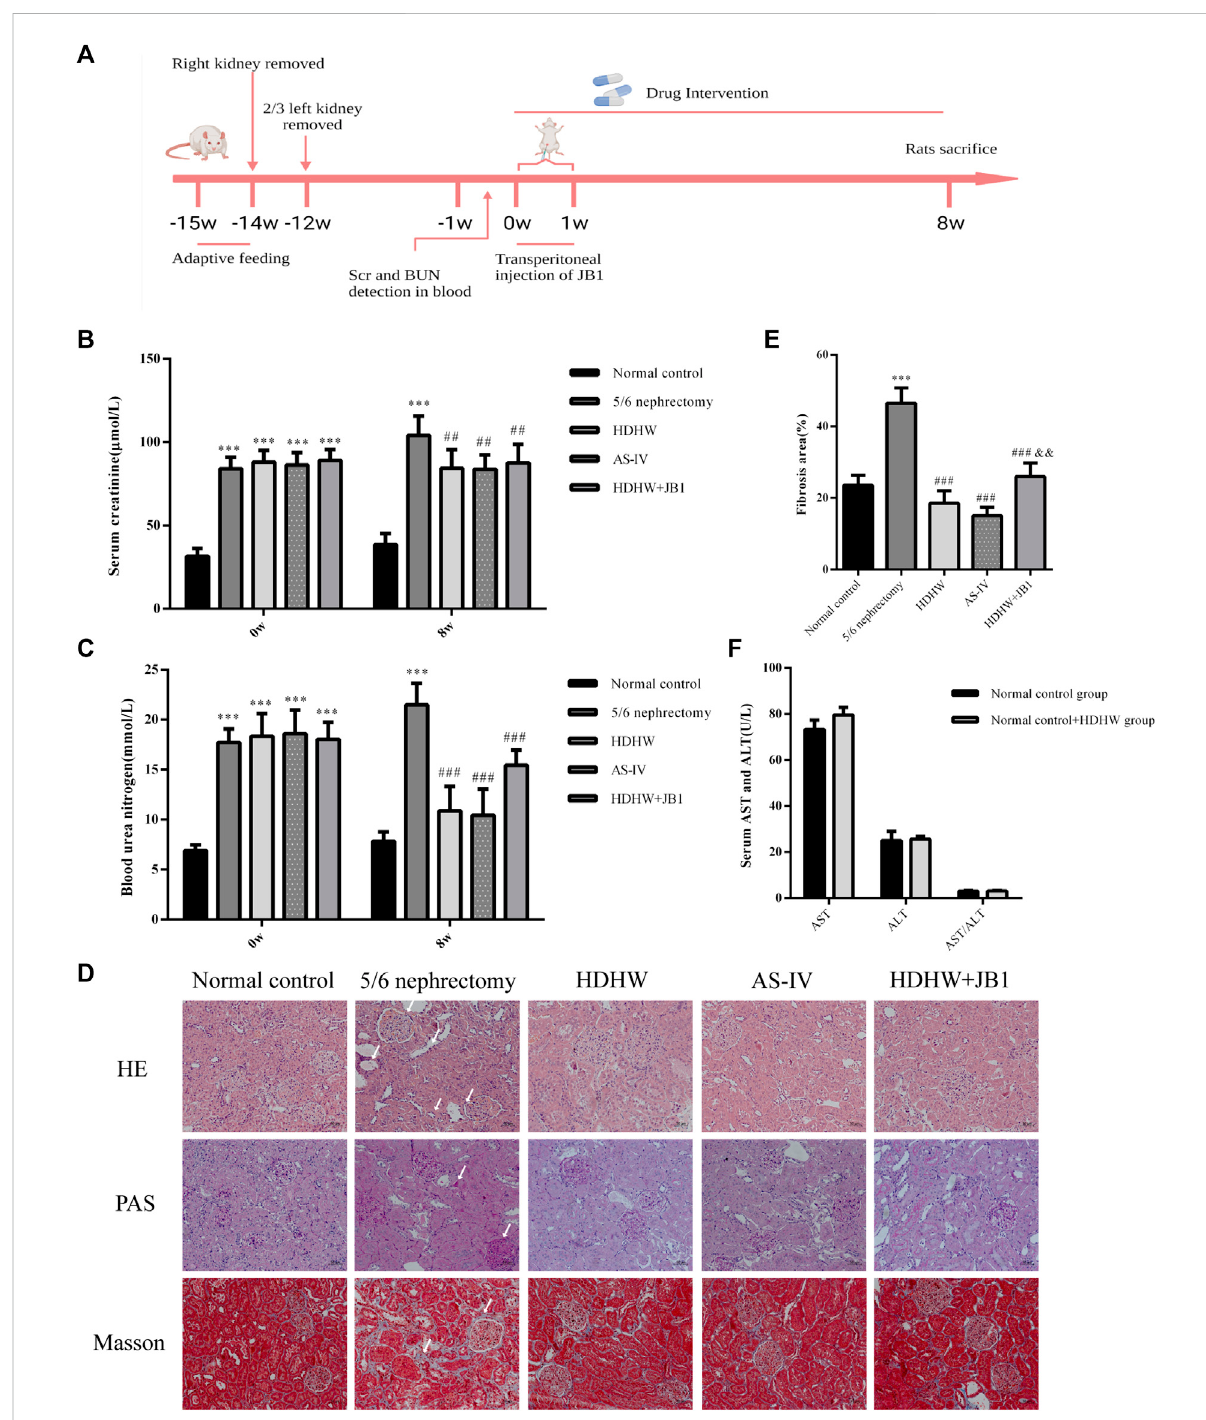
FIGURE 2 HeidihuangWan (HDHW) improves renal function and renal pathological damage in 5/6 nephrectomized rats. (A) Timeline of animal experiments. (B) Serum creatinine (Scr) and (C) blood urea nitrogen (BUN) levels before and after 8 weeks of drug intervention. (D) Hematoxylin- Eosin (HE), Periodic Acid-Schiff (PAS), Modi fi ed Masson ’ s Trichrome (Masson) staining. Collagen fi ber deposition was observed in the 5/ 6 nephrectomy group (arrows). (E) The degree of renal fi brosis was calculated using ImageJ software. (F) Serum aspartate aminotransferase (AST) and alanine aminotransferase (ALT) levels after drug intervention. Data are presented as mean ± SD, n = 6. The data are expressed as *** p < 0.001: compared with normal control group; ## p < 0.01, ### p < 0.001: compared with 5/6 nephrectomy group; && p < 0.01: compared with HDHW group,